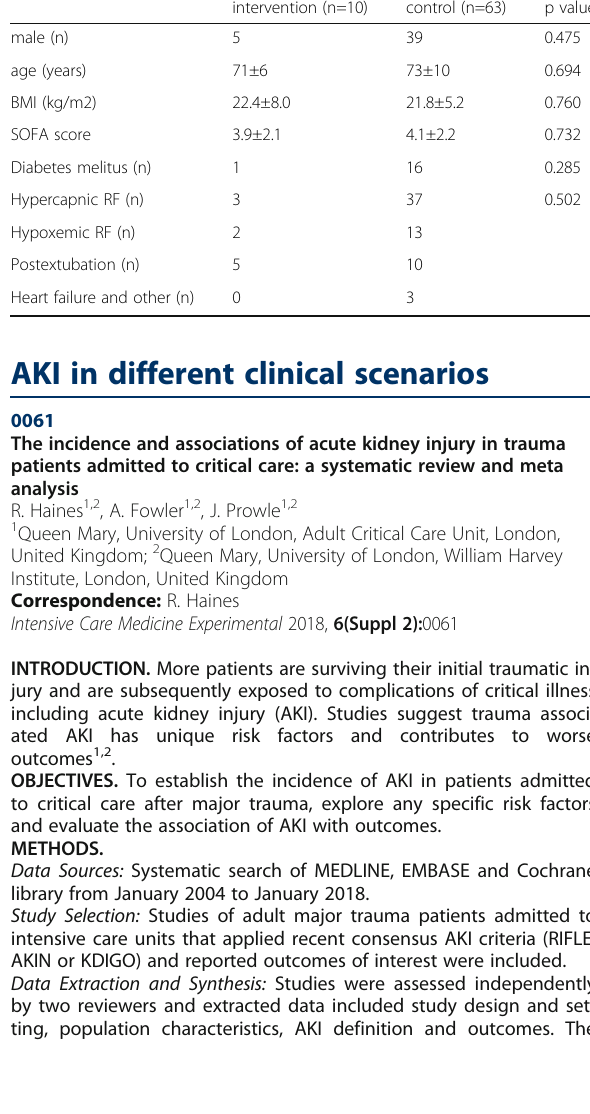
table 1. We divided the intervention group that who received man- agement of pain, sedation and control group. The pH, PaCO2 and PaO2/FoiO2 ration before NIV and 30 minutes after NIV were not dif- ferent between intervention and control group. The number of fail- ure were 5 (50%) in intervention and 21 (33%) in control (p=0.51). The hospital mortality rate was 30% in intervention and 21% in con- trol (p=0.581). CONCLUSIONS. The management of pain, sedation was performed in 14 percent of NIV patients. Small numbers of patients are limited. The control of pain, sedation might be safe during NIV.